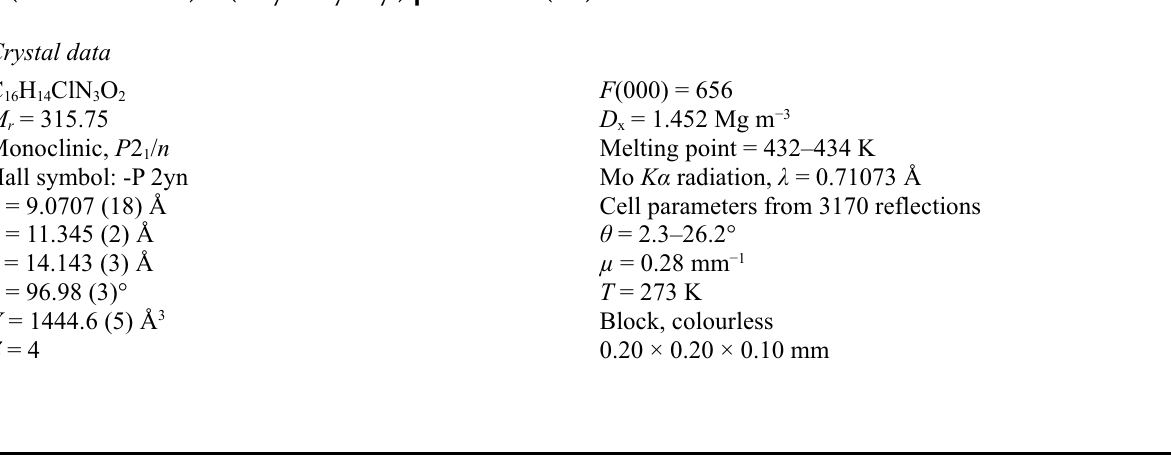
Crystal packing viewed down the a axis. Hydrogen bonds are shown as dashed lines. 2-(4-Chloroanilino)-3-(2-hydroxyethyl)quinazolin-4(3 H